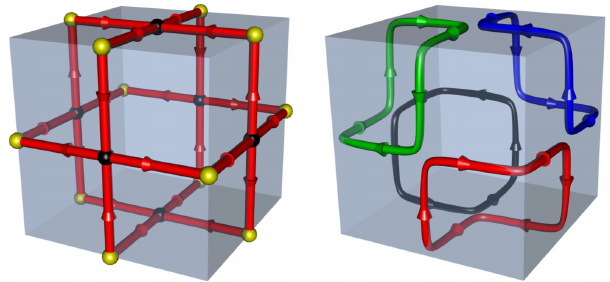
FIG. 1. Structure of L lattice. Left figure: Nodes and links (with associated orientations) in the unit cell of the L lattice. The two sublattices of nodes are indicated. Right figure: One of the four equivalent packings of minimal-length loops on this